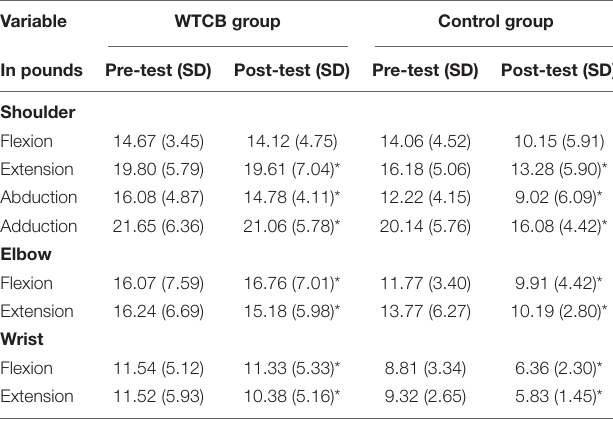
TABLE 1 | Means and SDs of the muscle strength of the upper extremity between the WTCB group and control group. Variable WTCB group Control group